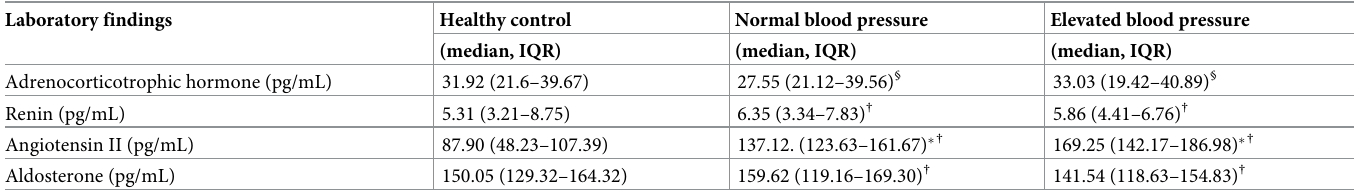
The normal and elevated blood pressure groups were compared with the healthy control group, respectively, by Student’s t test or the Mann-Whitney test ( § Two- Sample T-test, † Mann Whitney U test/Wilcoxon Sum Rank